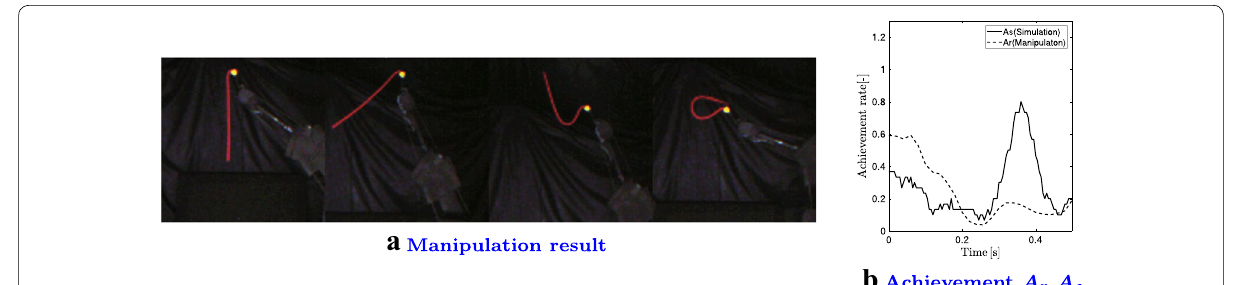
Fig. 23 Manipulation result for desired image of string shape: J with the estimated parameter for C